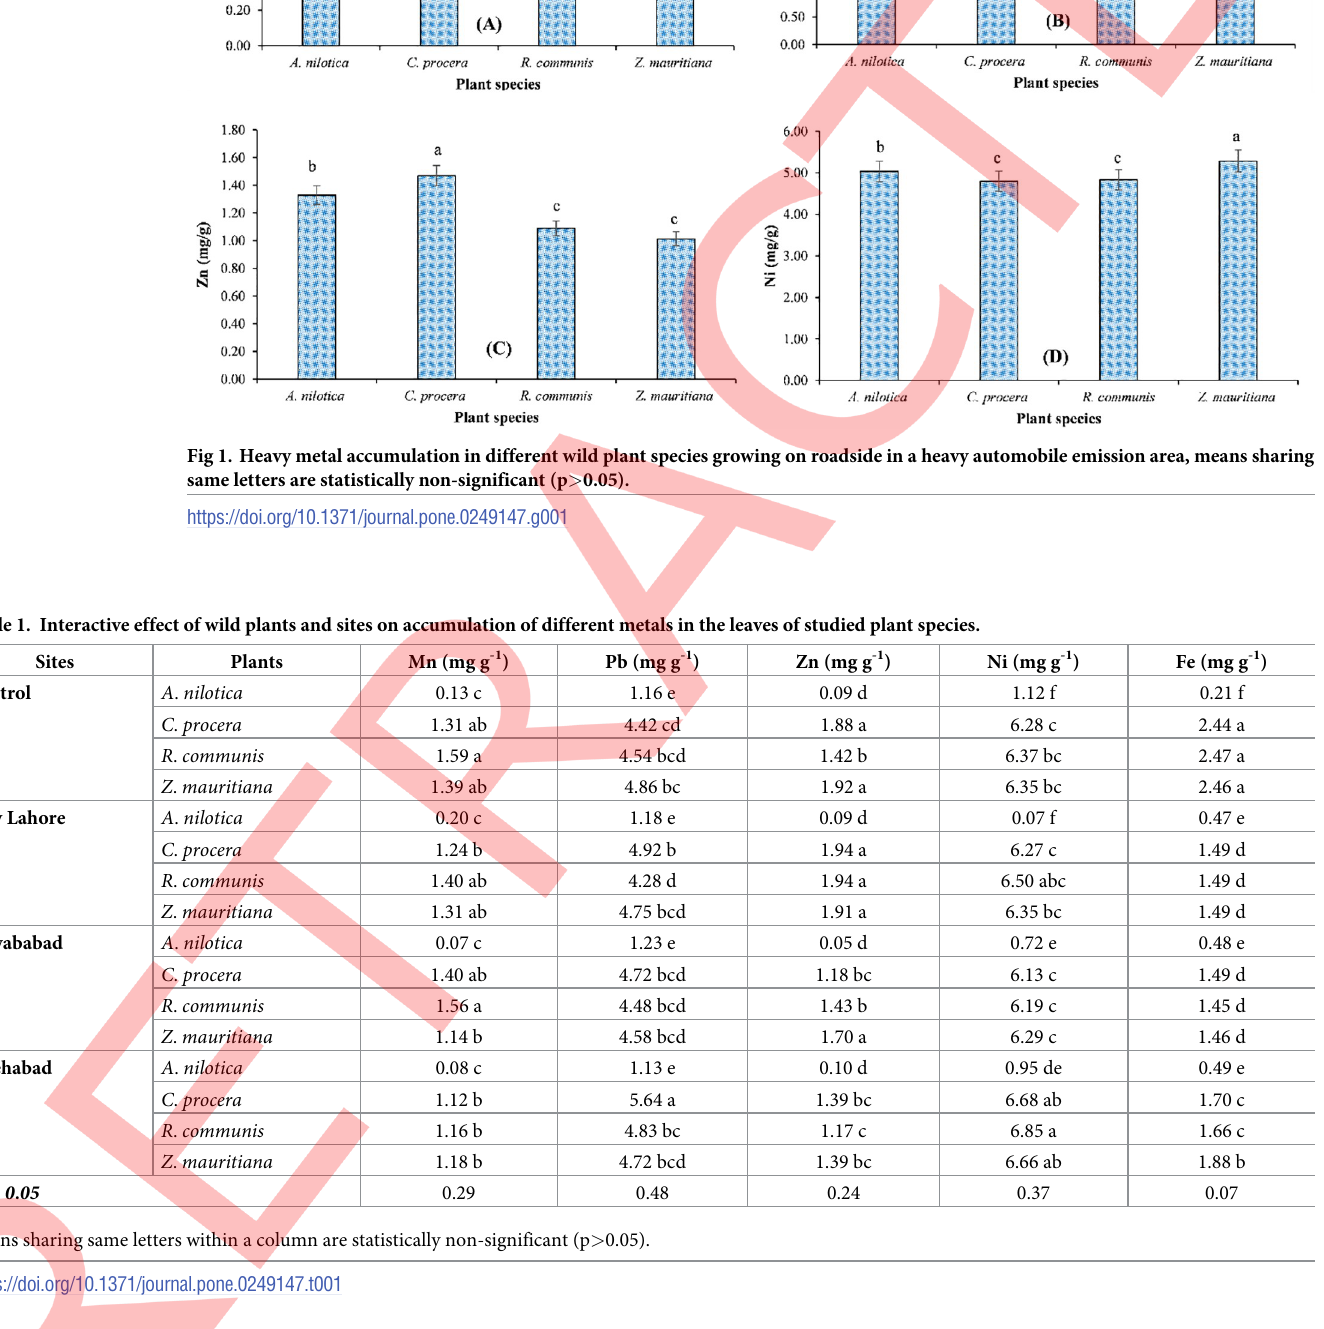
Means sharing same letters within a column are statistically non-significant (p >